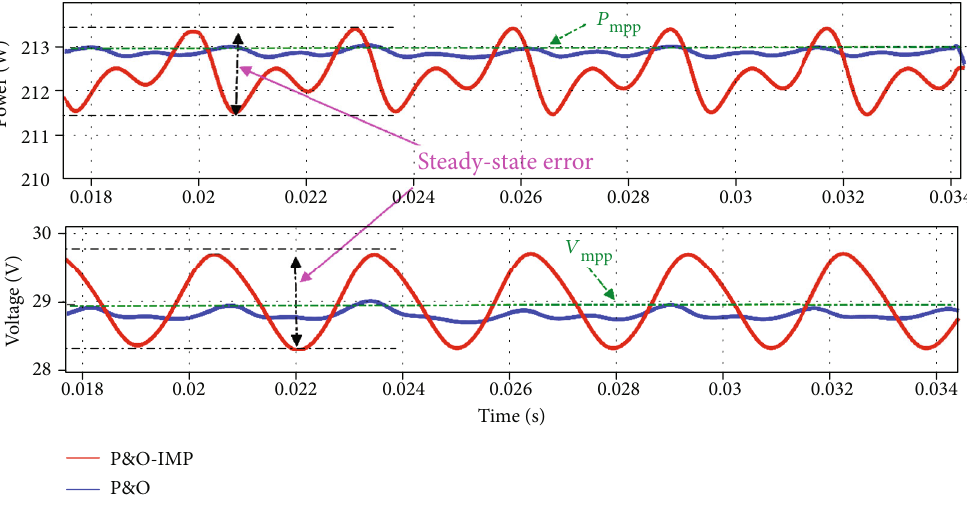
Figure 18: Comparison of the voltage and power in the steady state at G = 1000W/m 2 and T = 25 ° C